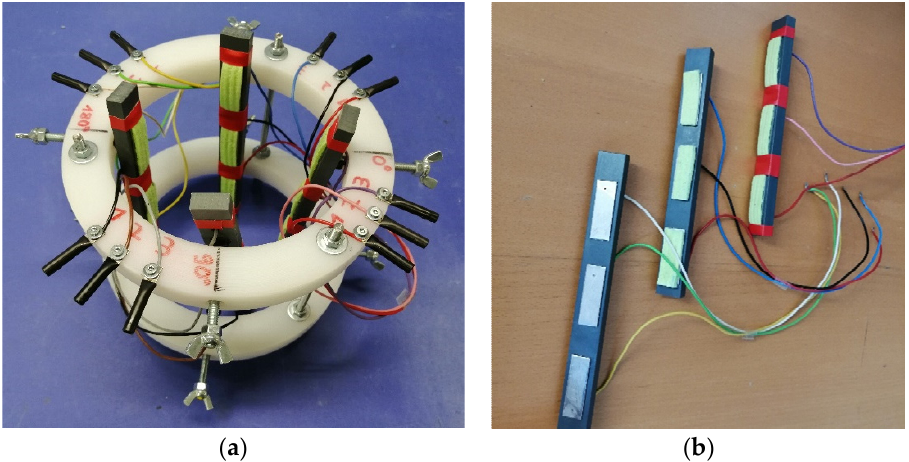
Figure 3. Cylindrical frame with 12 stainless steel electrodes on three height levels with angular distances of 90° ( a ) and electrodes with covering and isolation ( b ).